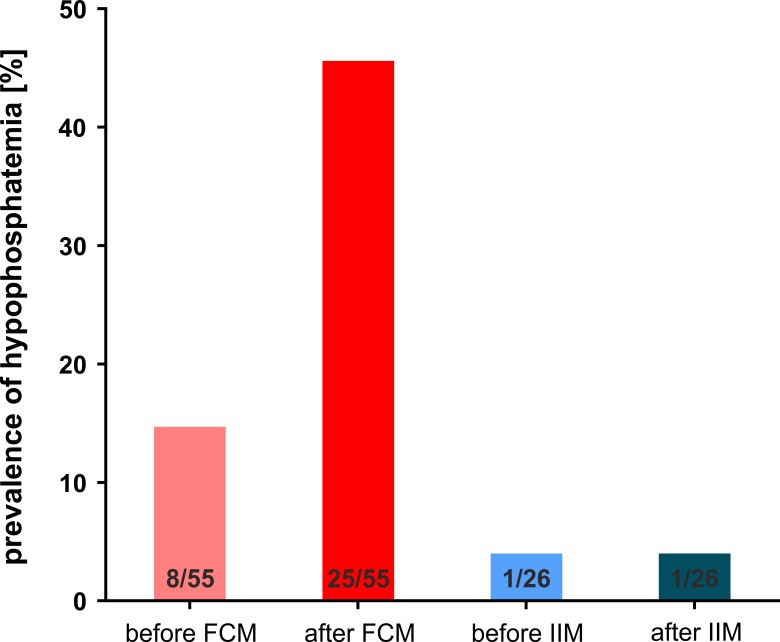
Prevalence of hypophosphatemia before and after FCM and IIM.